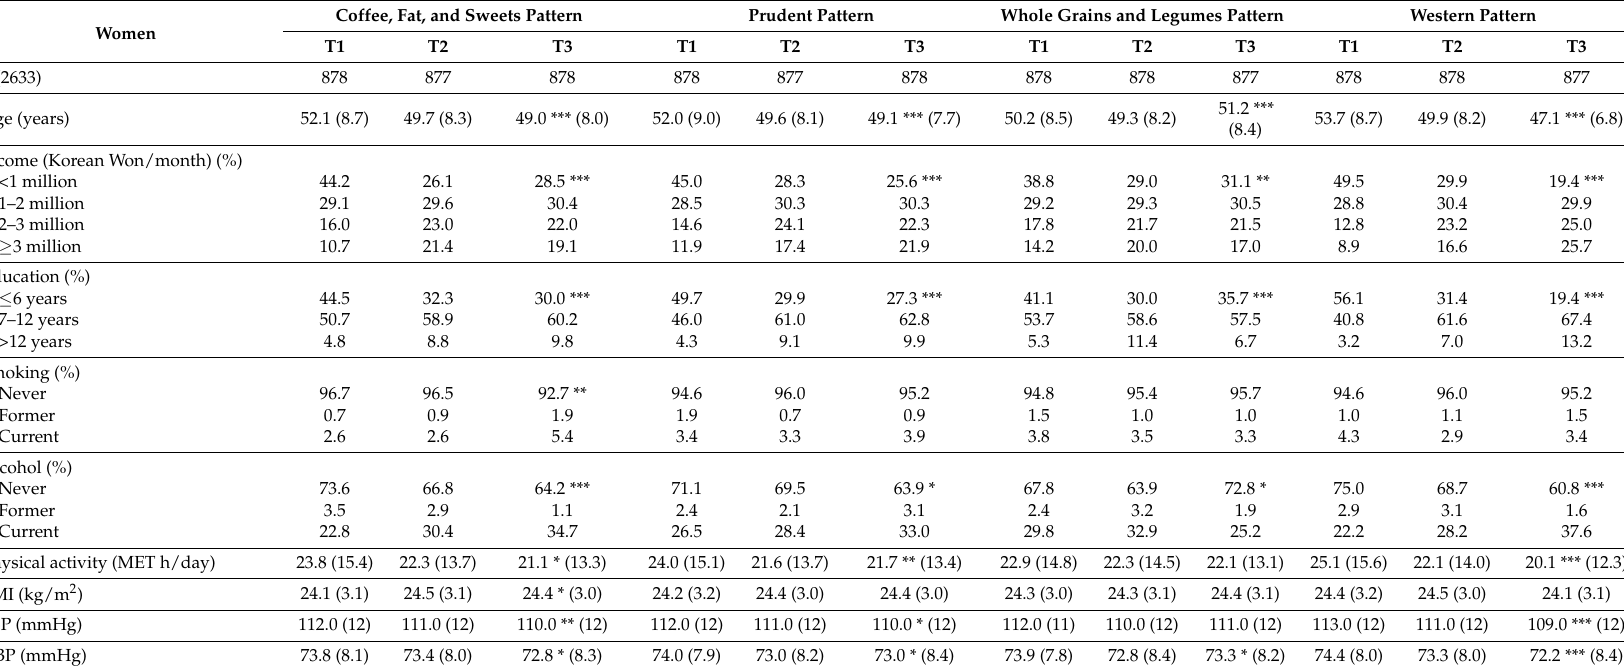
Table 3. Characteristics of the study participants according to the tertiles (T) of dietary pattern scores in women 1,2